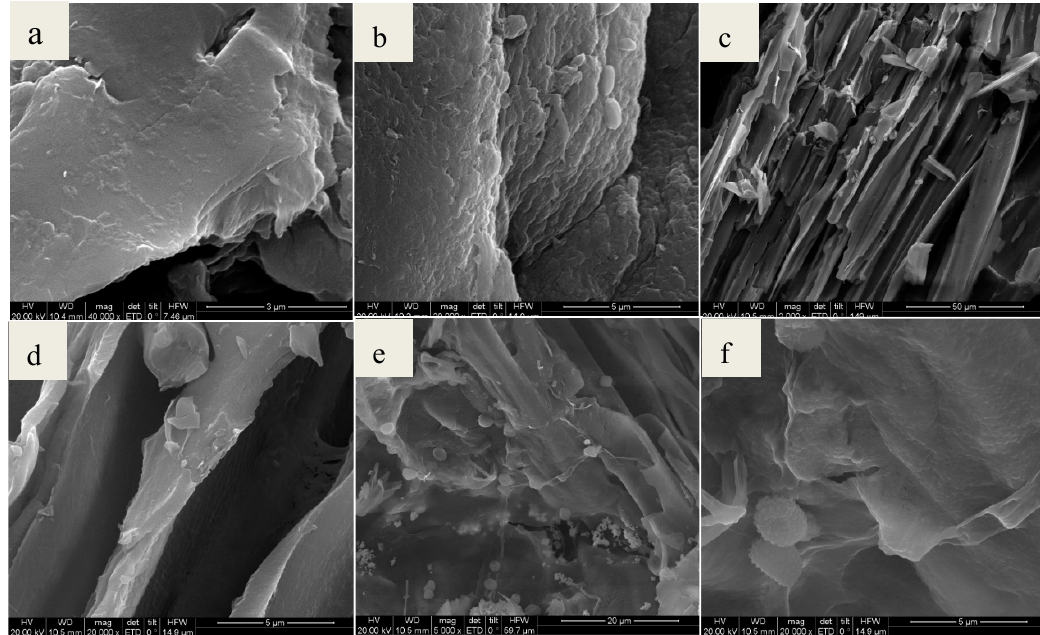
Figure 1. SEM images of ( a ) chitosan; ( b ) chitosan-BiFeO 3 ; ( c ) and ( d ) chitosan-kenaf biochar; ( e ) and ( f ) CKB.